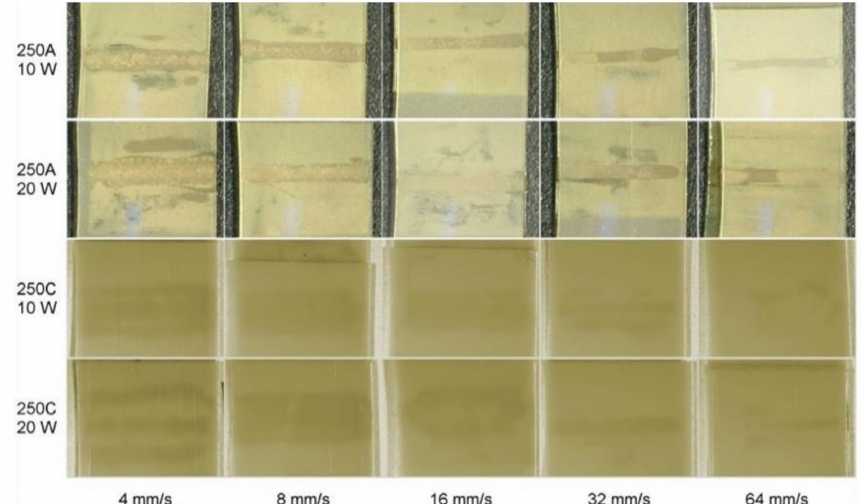
Figure 20. Optical micrographs of the joints before mechanical testing with varying laser power and scanning speed. HAZ disappearing with the increase in scanning speed (64 mm/s). Reproduced with permission from Ref. [10]. Copyright (2010), Materials and Design.